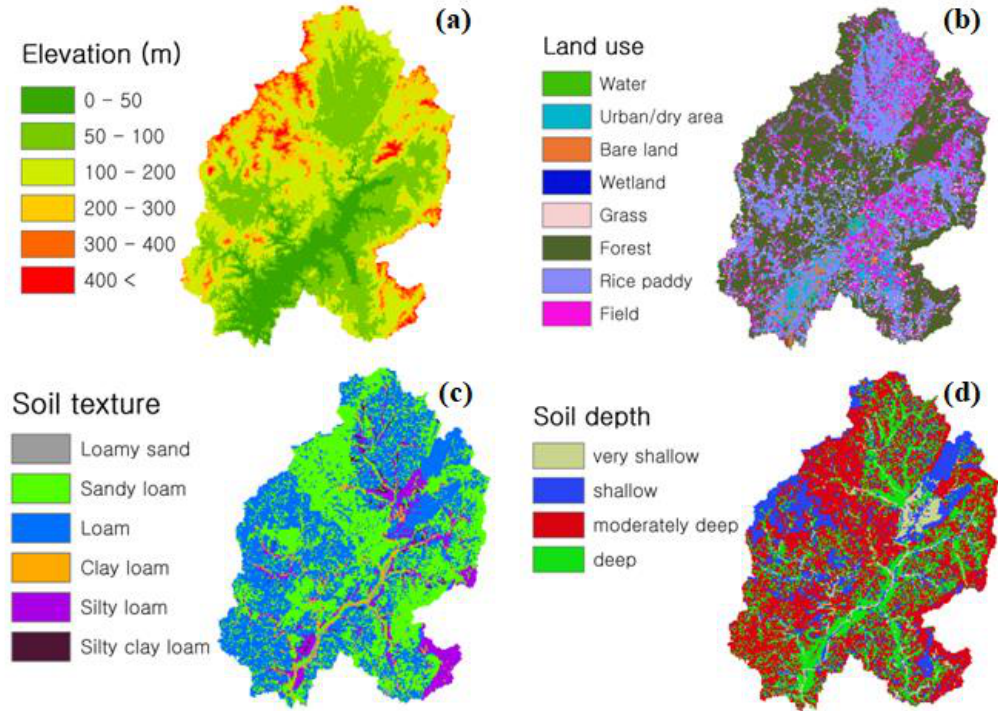
Figure 2. Geographic data of the Mihocheon watershed. ( a ) Digital elevation model (DEM) elevations, ( b ) land use, ( c ) soil texture, and ( d ) soil depth. The cell size is 250 × 250 m.